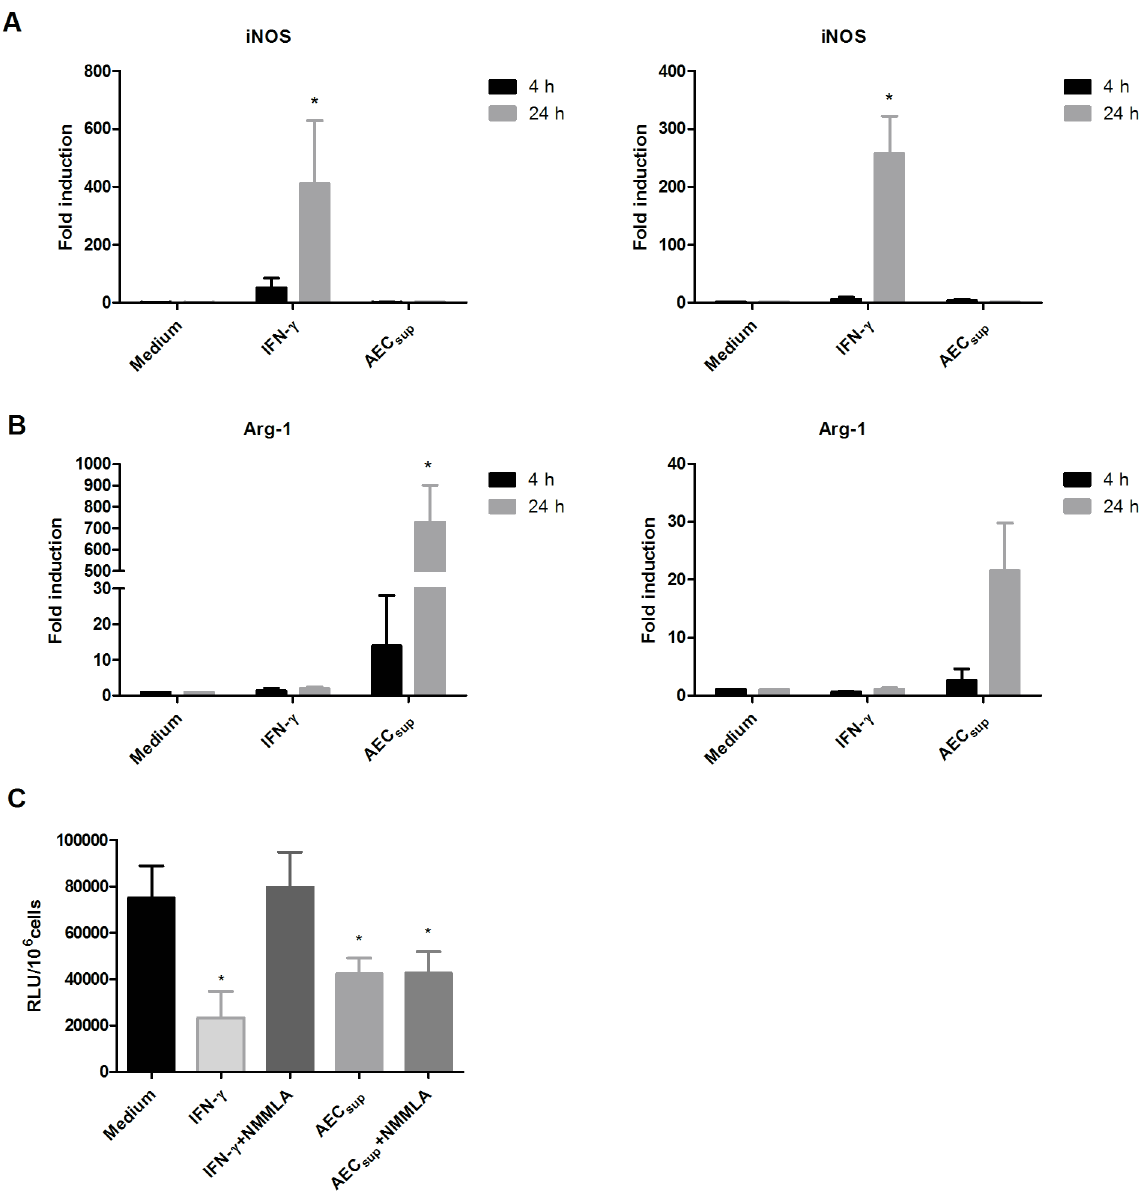
Figure 5. AEC sup has opposite effects to IFN- c on iNOS, and Arg-1 expression in BMM and PuM and mediates killing through an iNOS independent mechanism. BMM and PuM were infected with GFP-BCG. After infection, cells were treated with either IFN- c or AEC sup or 1 mM of NG-monomethyl-L-arginine (NMMLA) together with either IFN- c or AEC sup or left untreated. Total RNA was extracted from both cell-types after 4 and 24 h of treatment and the mean-fold accumulation of a) iNOS, b) Arg-1 6 SD from 3-4 experiments. In c) the effect of the iNOS inhibitor NMMLA on intracellular growth of BCG is shown. Bacterial growth was evaluated by determining RLU. Data are expressed as mean 6 SD. The differences between groups of BMM and PuM were analyzed using non-parametric, one-way ANOVA (Kruskal-Wallis) with Dunn‘s post-test. * significantly different from medium control, P , 0.05